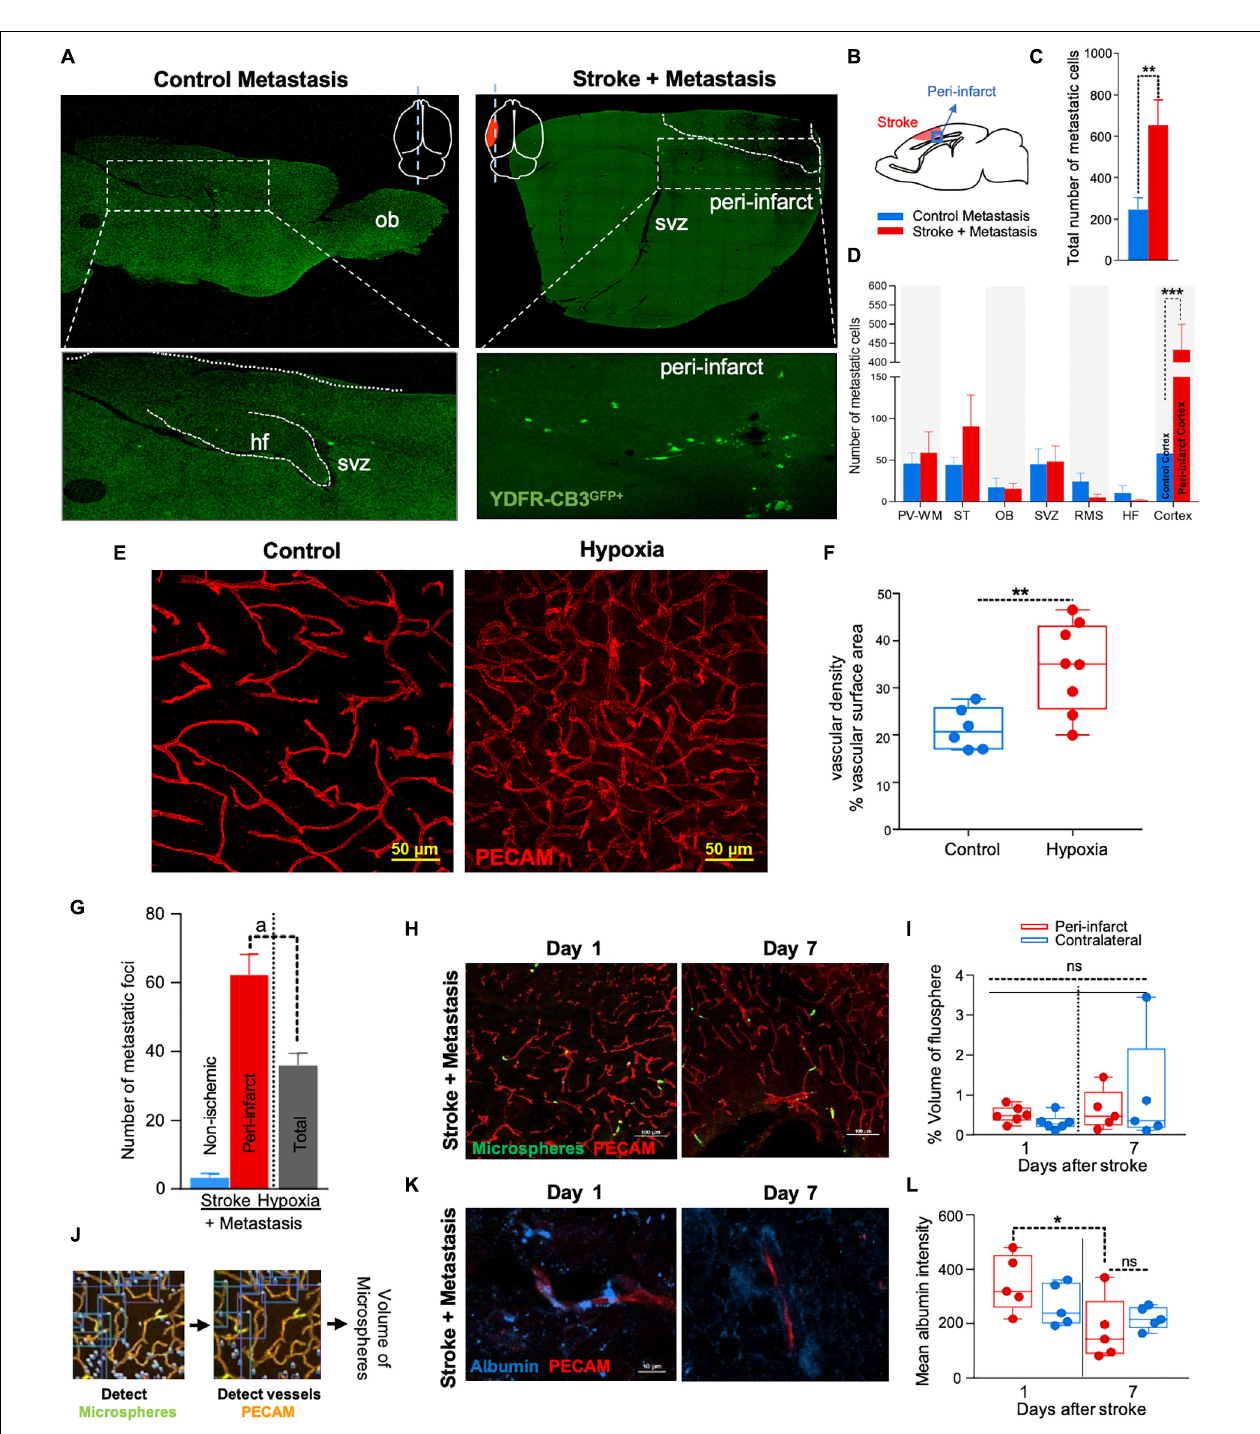
FIGURE 1 | The regenerative neurovascular niche after stroke facilitates brain metastasis. (A) Representative brain images from control and stroke groups subjected to melanoma metastasis shown in the top panel. GFP + cells identifies brain metastatic melanoma at high magnification in the bottom panel. (B) Schematics showing region from stroke brains and corresponding regions in control quantified. (C) Bar graphs of total number of metastatic cells in both control and stroke groups and (D) showing quantification and distribution of metastatic cells in different brain regions as mean ± SEM ( n = 6–7, four sections per animal, ∗∗ p = 0.0082, ∗∗∗ p = 0.0012 Mann–Whitney, two-tailed t -test). PV-WM, periventricular white matter; ST, striatum; OB, olfactory bulb; SVZ, subventricular zone; RMS, rostral migratory stream; HF, hippocampus. (E) Representative images depicting vascular density in control and hypoxia + metastasis group. (F) Box and scatter plots with minimum and maximum percentage vascular density (surface area µ m 3 ) mean ± SEM ( n = 6–8), ( ∗∗ p = 0.0090 unpaired, two-tailed t -test) (G) Stroke increases.